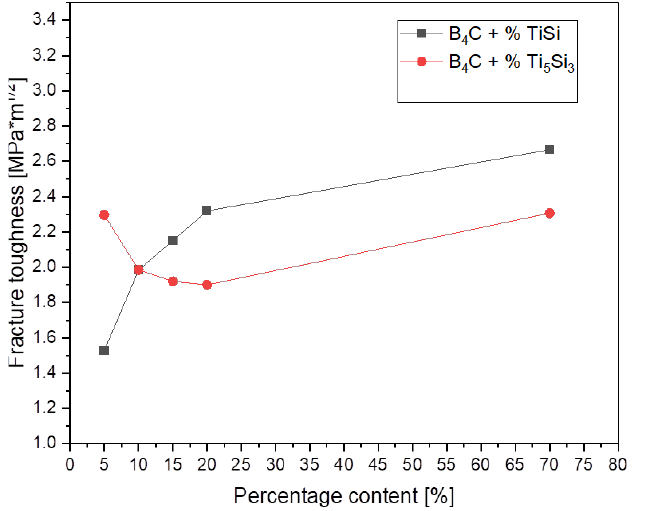
Figure 5. Fracture toughness of the composites as a function of the percentage of various additives. The X-ray diffraction analysis of the composites showed that for an increasing amount of intermetallic (TiSi 2 and Ti 5 Si 3 ) additives, the percentage of the new phase, i.e., the titanium boride (TiB 2 ), increased (Table 2). The quantitative content of graphite in the sinter with a 15% additive is much greater than in the sinter with boron carbide without the use of the additive. This is because after the complete conversion of Ti 5 Si3 with B 4 C, TiB 2 and SiC phases are formed in the system and the excess carbon (C) from the B 4 C decomposition remains. The reaction takes place this way because titanium (Ti) has a greater affinity for boron (B), while silicon (Si) reacts with carbon (C) first. The reaction proceeded with 100% efficiency because we do not observe the presence of the Ti 5 Si 3 or TiSi 2 phases. When increasing the amount of intermetallics, in samples from 5–20% of the additive, we do not observe unreacted intermetallic residues, and on the diffraction patterns of the commercial boron carbide sinter with a stoichiometric amount of the additive used, a partial conversion of titanium silicide (Ti 5 Si 3 or TiSi 2 depending on the additive used) was recorded in the tested system. The percentage of the remaining phase in both cases was below 3% (Figure 6a,b), which confirms the thermodynamic calculations made with the assumption of the course of the reaction for both additives. In the phase composition of the previously observed phases, i.e., titanium boride (TiB 2 ) and silicon carbide (SiC), the presence of a new phase, i.e., titanium carbide (TiC), was also observed, with the simultaneous lack of graphite in the sample. Earlier thermodynamic considerations ruled out the appearance of titanium carbide (TiC), but its presence was registered due to inhomogeneities in the sample. Titanium silica (Ti 5 Si 3 ) in the observed place completely reacted with boron carbide (B 4 C), forming titanium boride (TiB 2 ) and silicon carbide (SiC). An excess amount of titanium (Ti) remained in the system, which began to react with the carbon resulting from the decomposition of boron carbide (B 4 C), resulting in the formation of a titanium carbide (TiC)